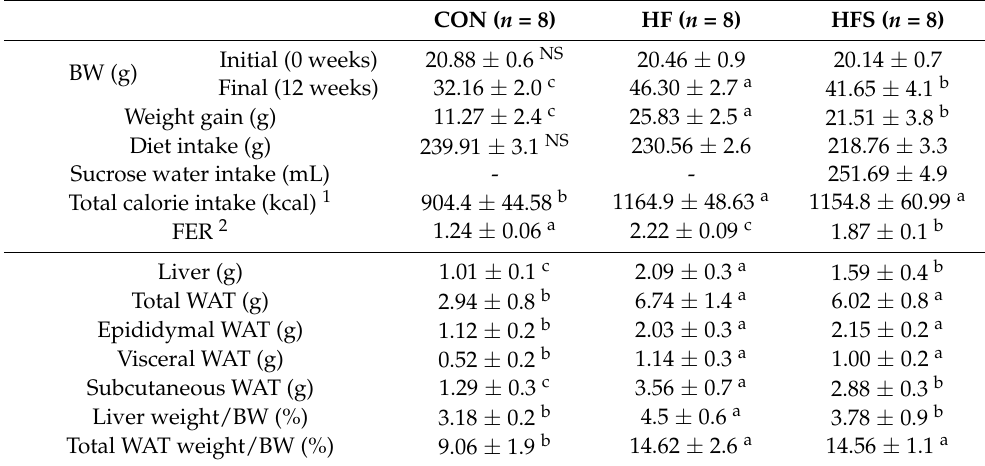
Table 2. Changes in BW, diet intake, FER, and organ weight from mice fed a conventional normal, HF, and HFS diet.